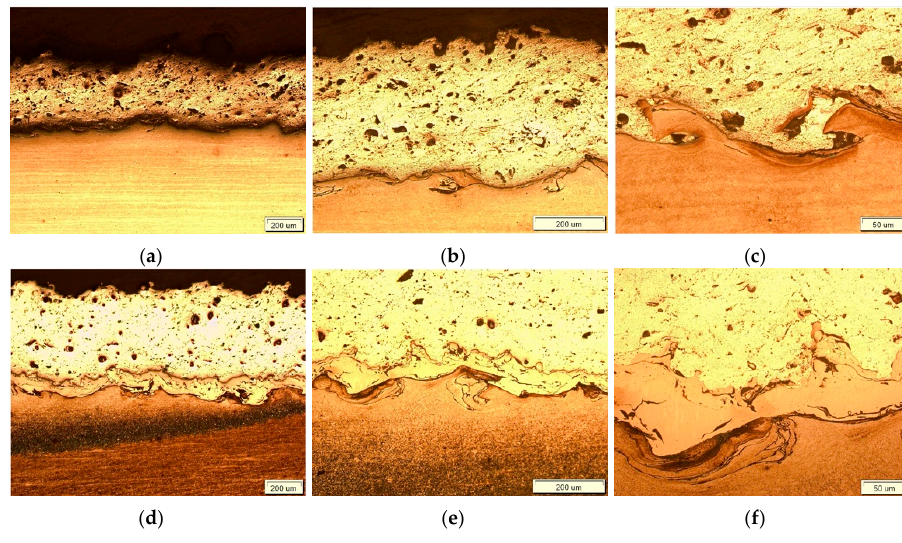
Figure 4. Images of the 01T grade wire arc-coated aluminum: ( a – c ) without buffering subcoating; ( d – f ) with wire-coated subcoating with 75B BondArc grade, Ni/Al alloy.